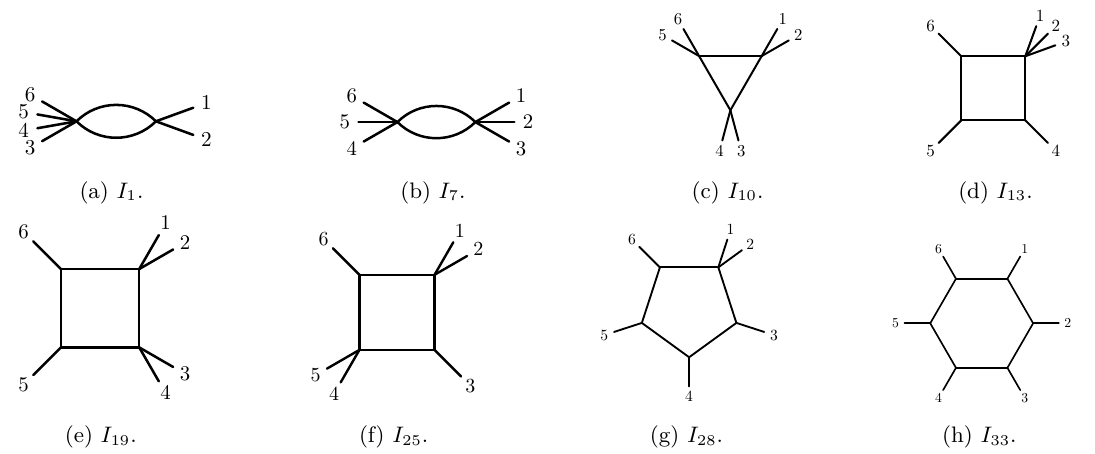
Figure 1. Graphical representations of the integrals in the IBP